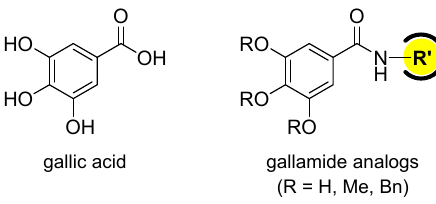
Figure 1. Gallic acid and its amide analogs.